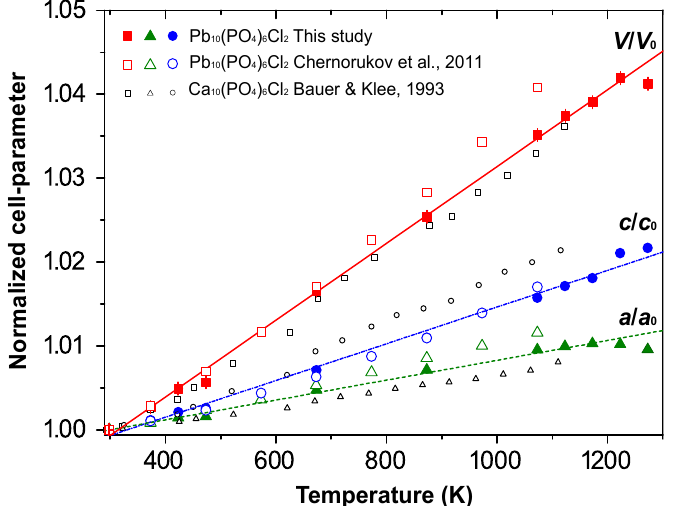
Figure 3. Variation of lattice parameters, normalized to the values at 298 K, as a function of temperature. Previous data for pyromorphite [12] and chlorapatite [18] are plotted for comparison.